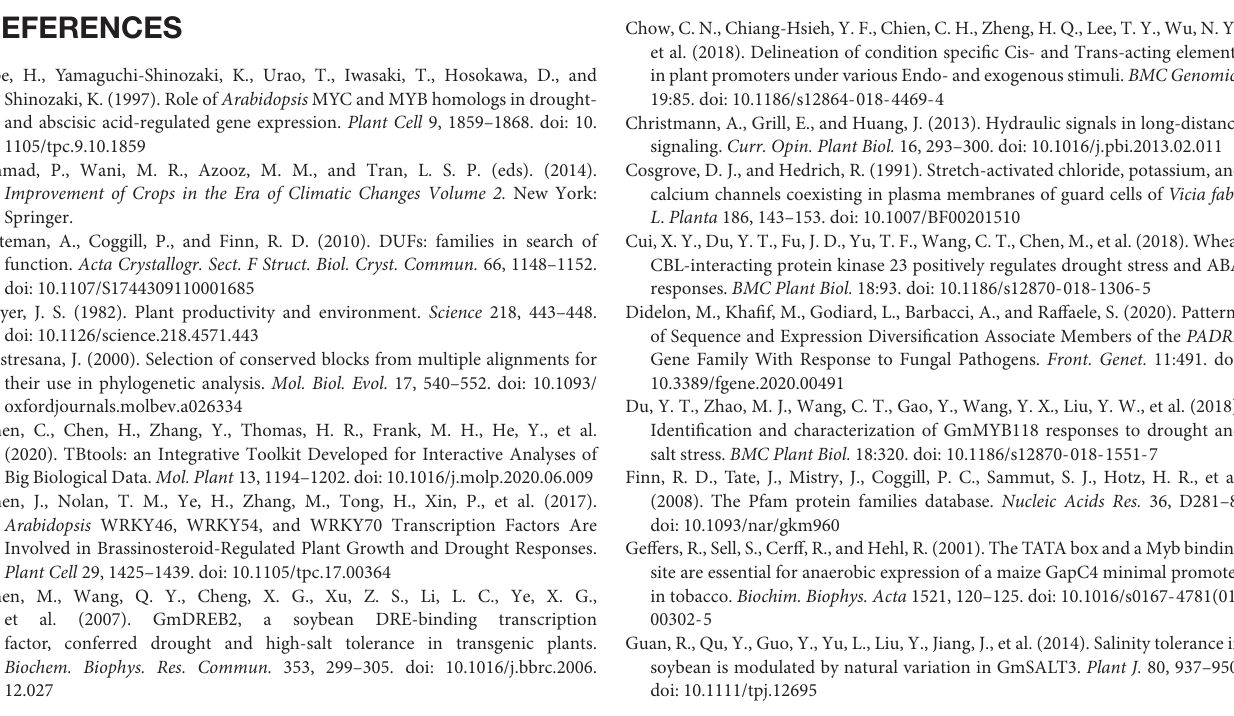
Supplementary Figure 1 | qRT-PCR analysis of GmDUF4228-70 expression level in EV and GmDUF4228-70 -OE transgenic hairy roots. Supplementary Table 1 | Primers and sequences used in this